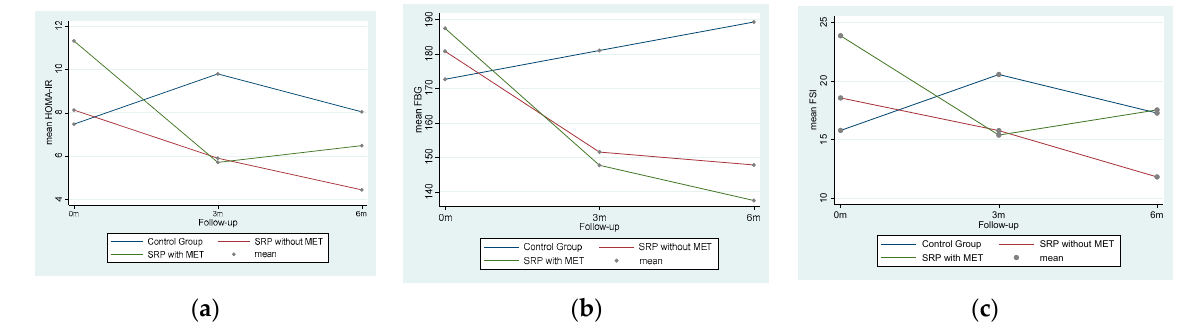
Figure 1. Profile plots of changes in mean HOMA-IR ( a ) over follow-up in three trial arms as a result of changes in FBG ( b ) and FSI ( c ).